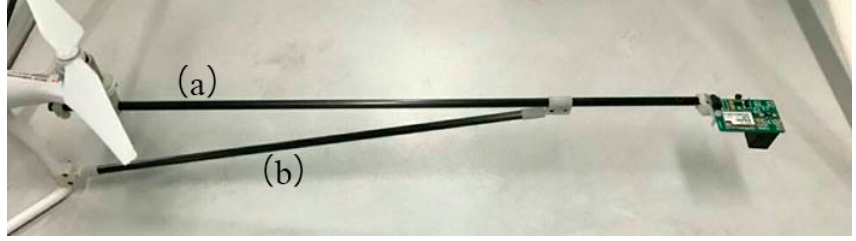
Figure 8. Design of UAV support and damping rod. ( a ) Support; ( b ) damping rod.